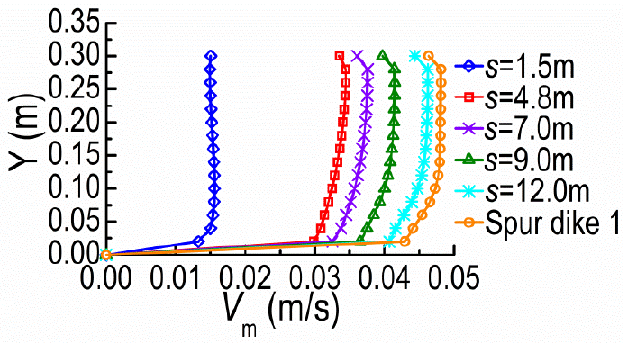
Figure 12. V m along Y-direction at the tip vicinity of SD2.